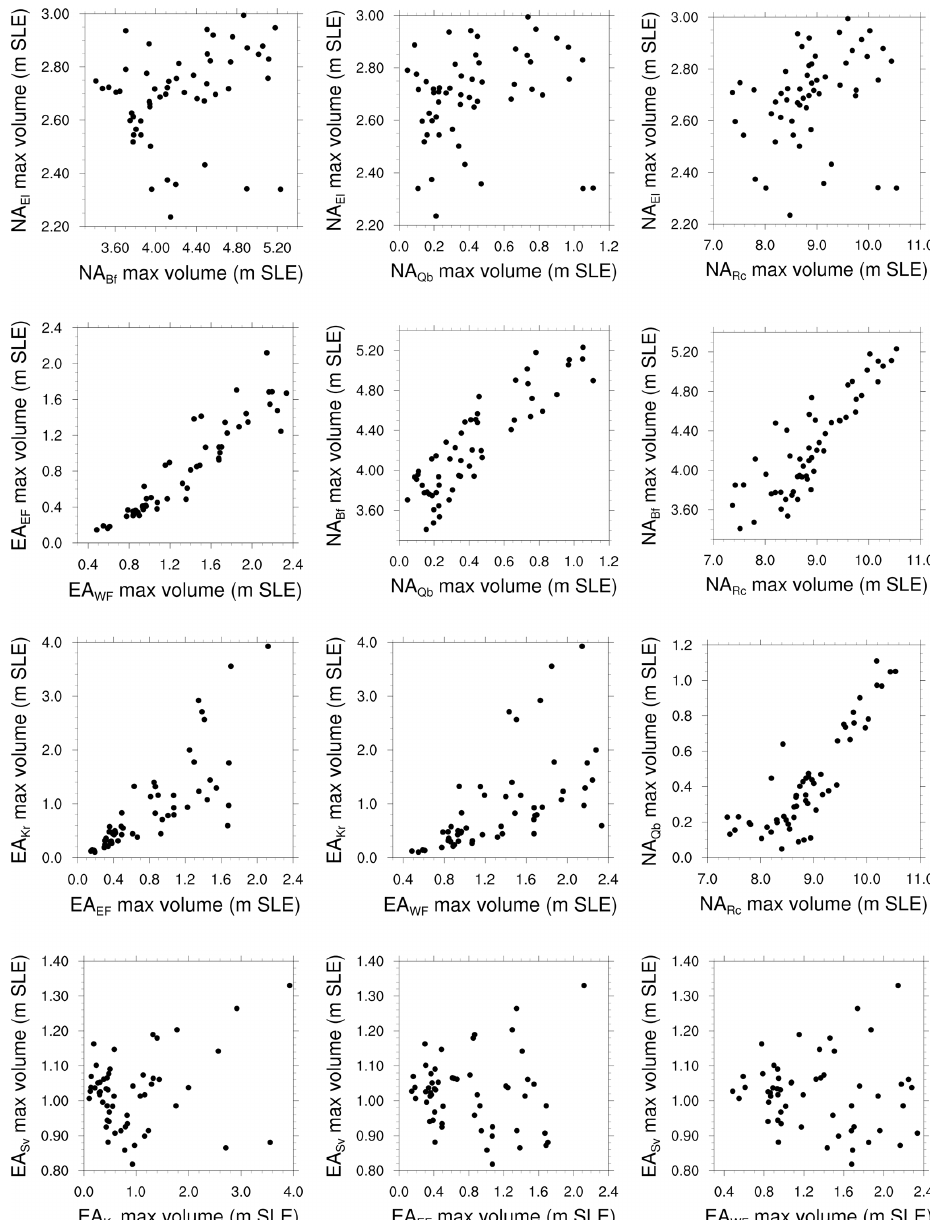
Figure 15. Correlation plots of maximum ice volume for NA and EA diagnostic sectors (Fig.